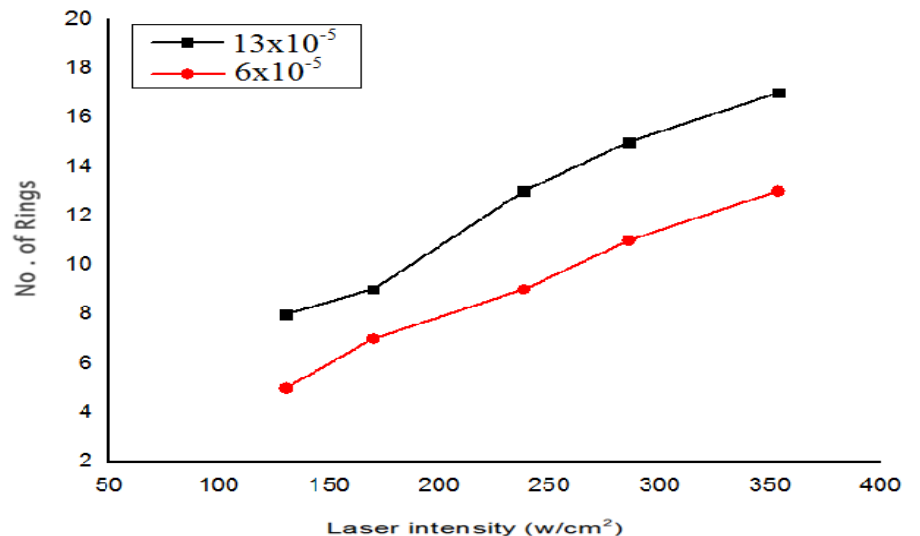
Fig.10: The diffraction rings of DI water (MWCNTs) suspension at different laser densities at volume fraction 13 × 10 - 5 and 6 × 10 - 5